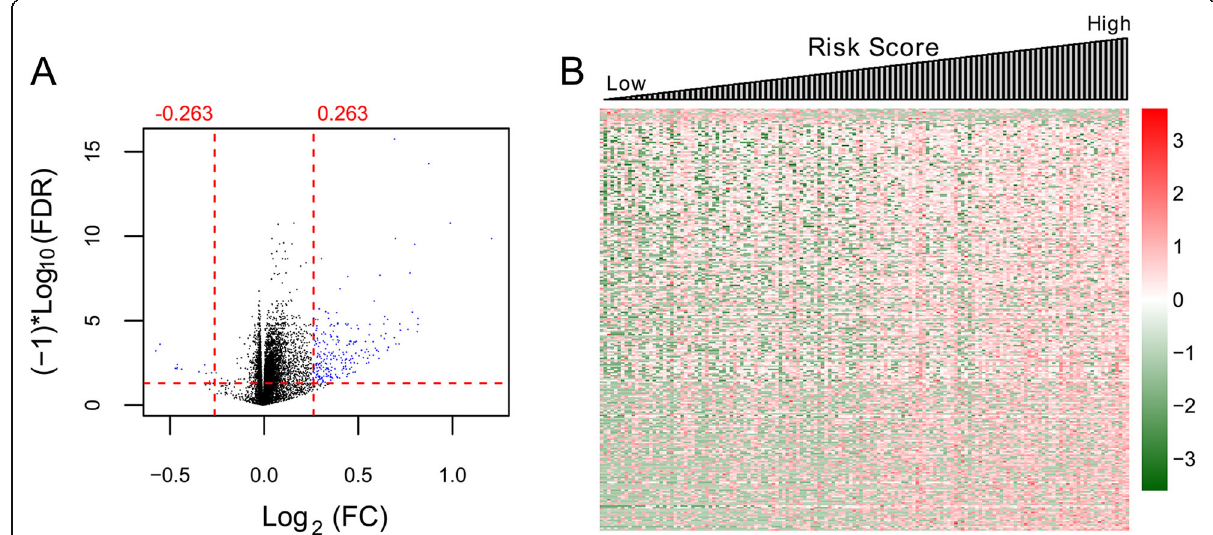
Fig. 6 Graphic demonstrations of DEGs between high and low risk subgroups of training set by the eight-mRNA signature. a , volcano plot of effect size (log 2 FC) and -log 10 (FDR) of the 266 DEGs. Blue and black spots represent significant DEGs and non-DEGs, respectively. b , risk score and expression levels of DEGs for patients in the high- and low-risk